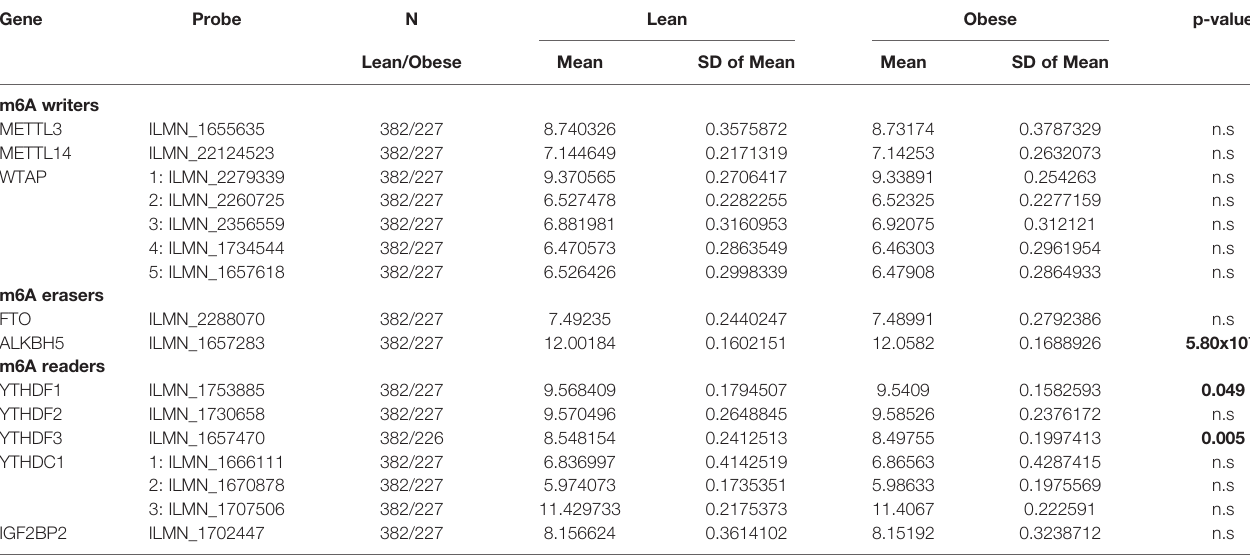
TABLE 5 | Comparison of mean gene expression of m6A regulators between lean and obese in the Sorbs cohort.